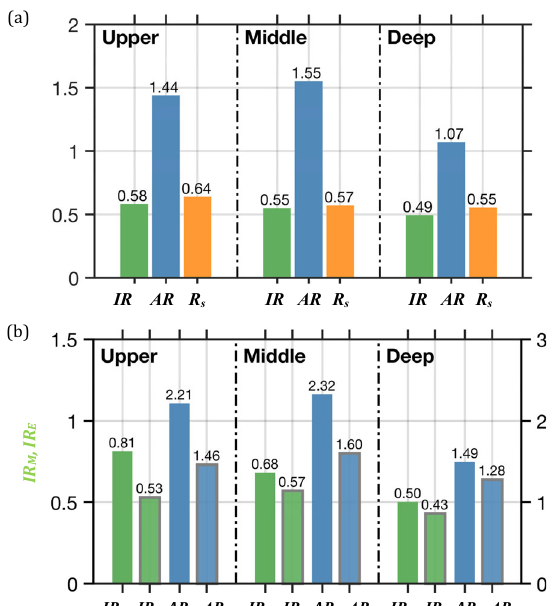
Fig. 3 Relative and absolute contributions of vorticity and MKE by the hotspots. a Annual mean values (bars and number) of IR vort (green), AR vort (blue), and ratio between shear vorticity and total vorticity R s (orange) in the hotspots for the three layers, respectively. b Similar to a , but for IR (M,K) and AR (M,K) of MKE and EKE , respectively.